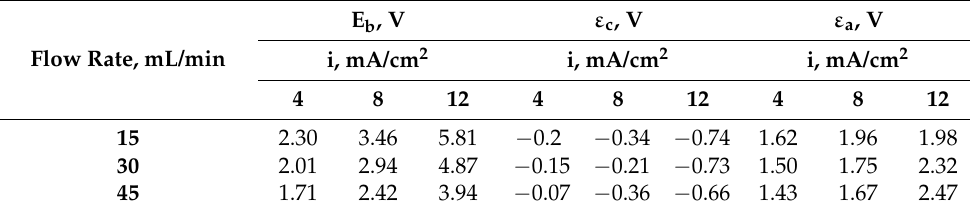
Table 2. Thermodynamic parameters of the electrochemical process. E b , V ε c , V ε a , V Flow Rate, mL/min i, mA/cm 2 i, mA/cm 2 i, mA/cm